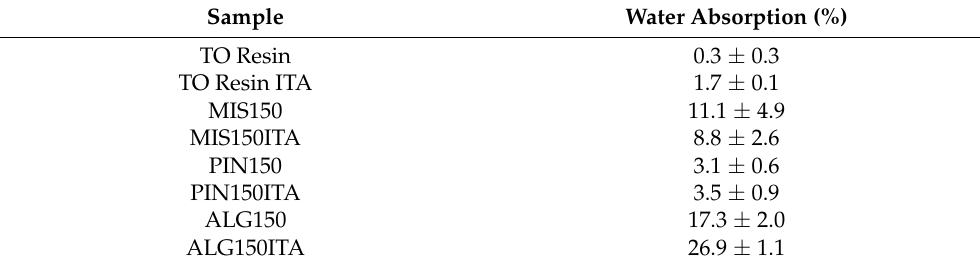
Table 4. Water absorption percentage of select composites and the unreinforced resin with and without